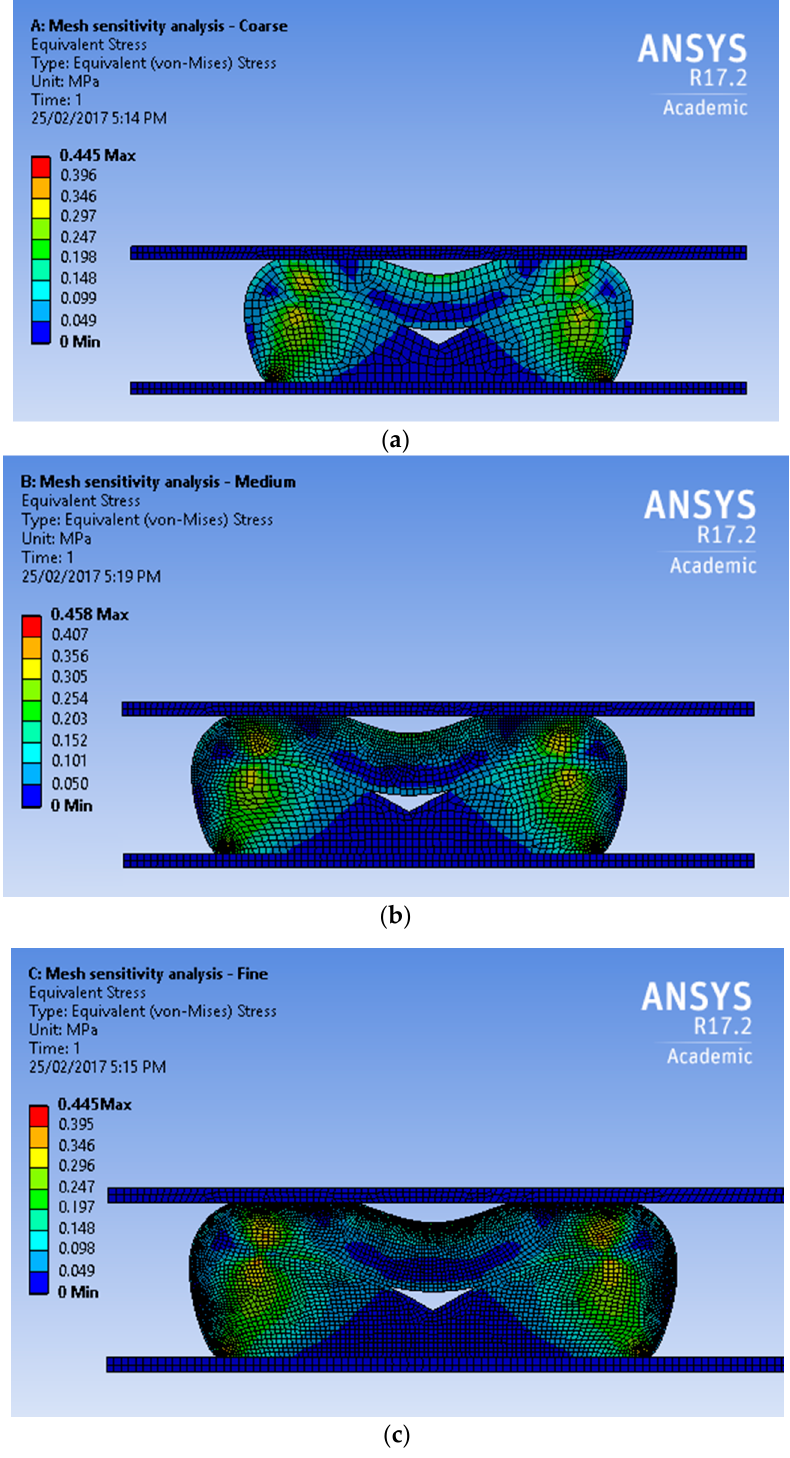
Figure 9. Geometry of the gasket seal after compression for identical loading cases: ( a ) Mesh A; ( b ) Mesh B; ( c ) Mesh C.